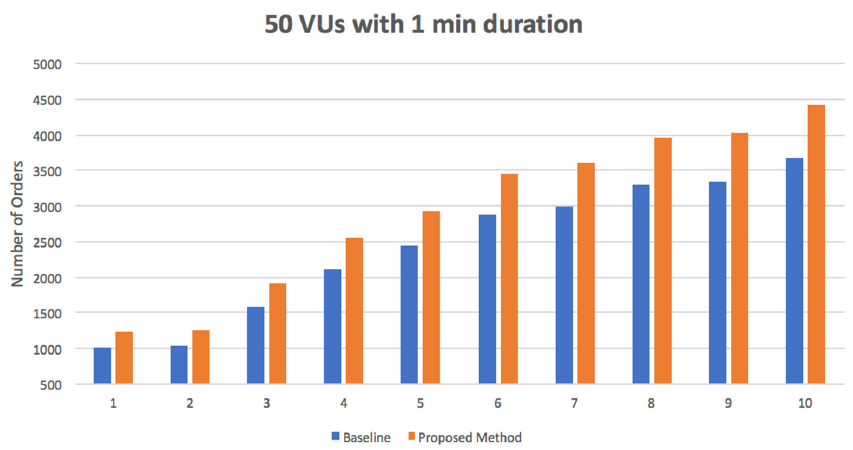
Figure 16. Load Testing—50 virtual users with 1 min duration.